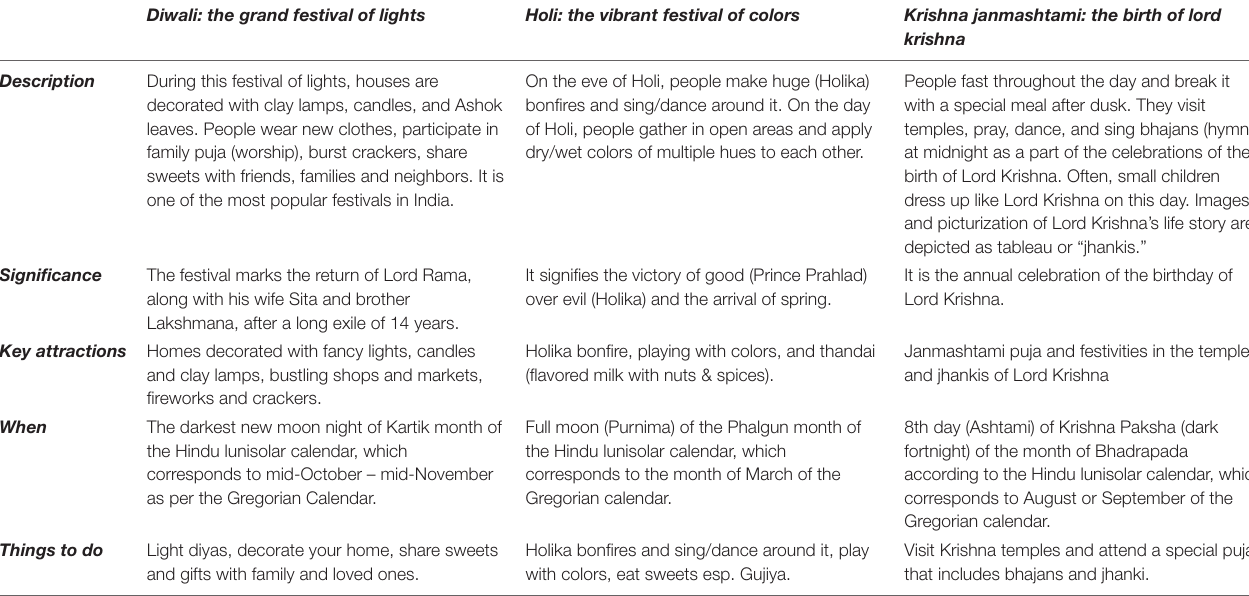
TABLE 1 | Prominent Indic festivals and their characteristic